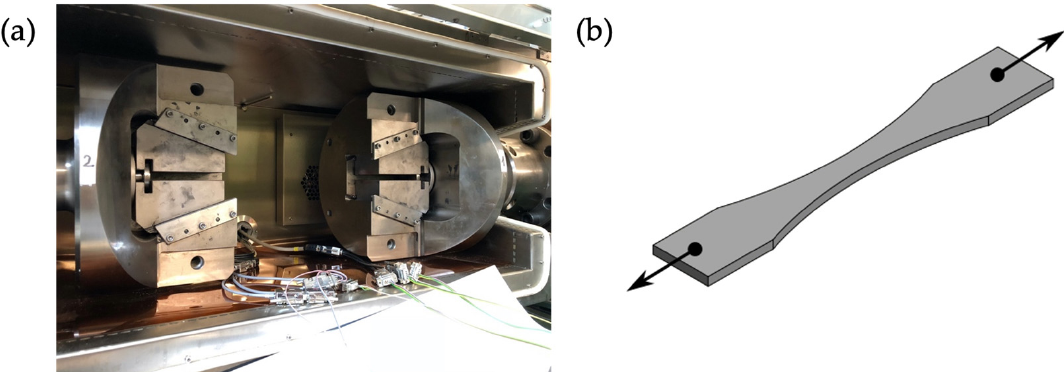
Figure 4. Temperature chamber that covers the clamping jaws of the horizontal testing machine ( a ) and uniaxial loaded specimen ( b